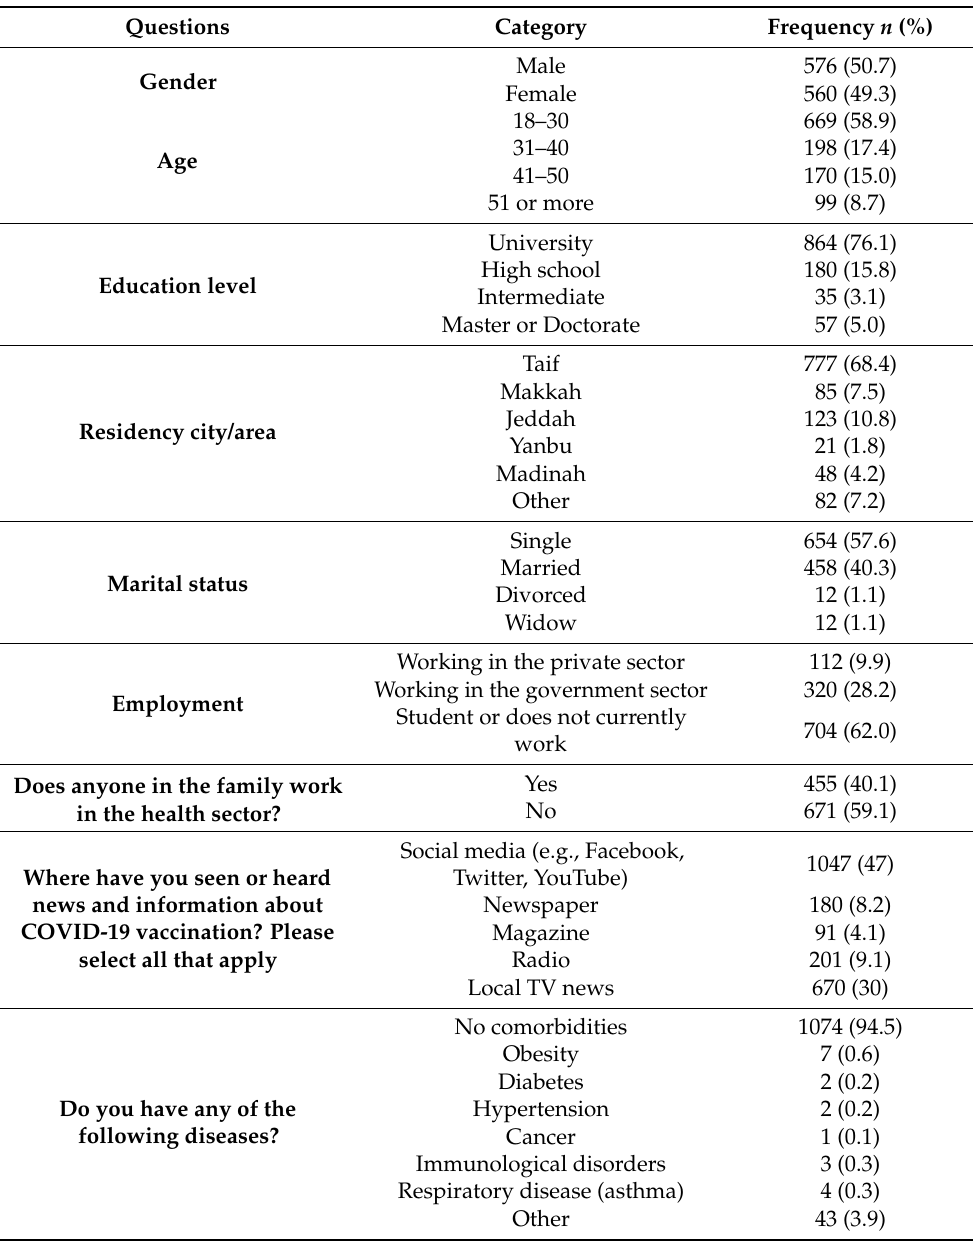
Table 1. Demographic